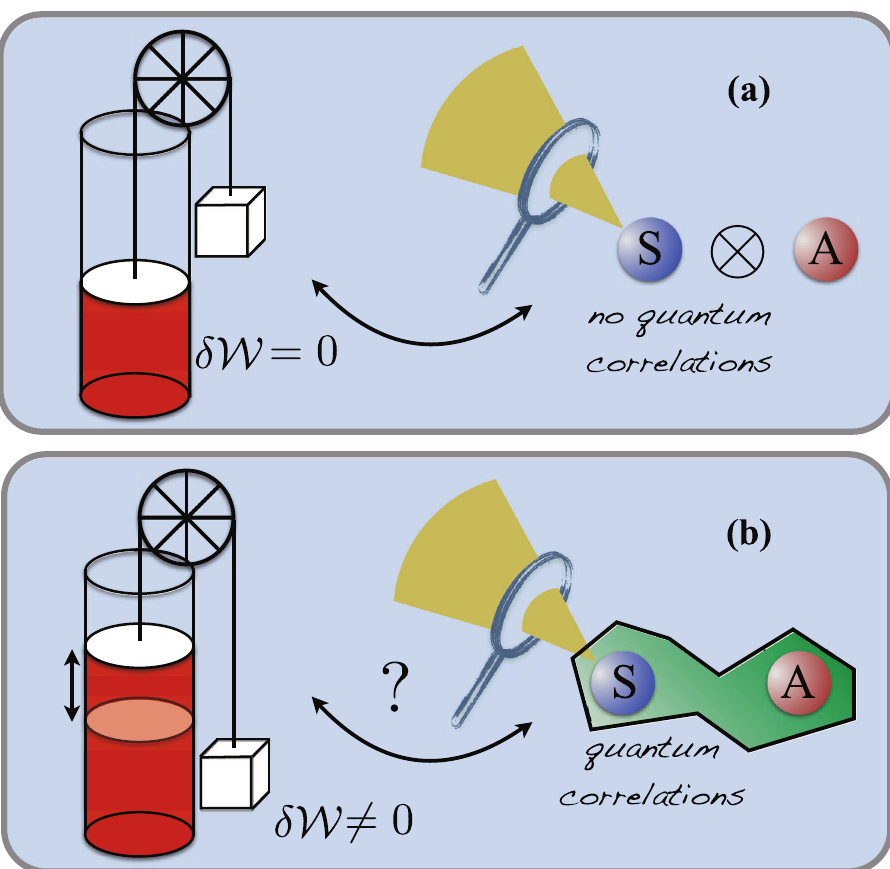
Fig. 1 a In our ancilla-assisted protocol, a null daemonic gain gain [i.e., δ W = 0, cf . Eq. (5)] implies the absence of quantum correlations between the system S and the ancilla A [as measured by the discord associated with measurements on S , cf . Eq. (6)]. b A non-null value of δ W , on the other hand, implies the possible existence of quantum correlations between S and A . For pure bipartite states (in arbitrary dimensions), the nullity of the daemonic gain is a necessary and suf fi cient condition for separability